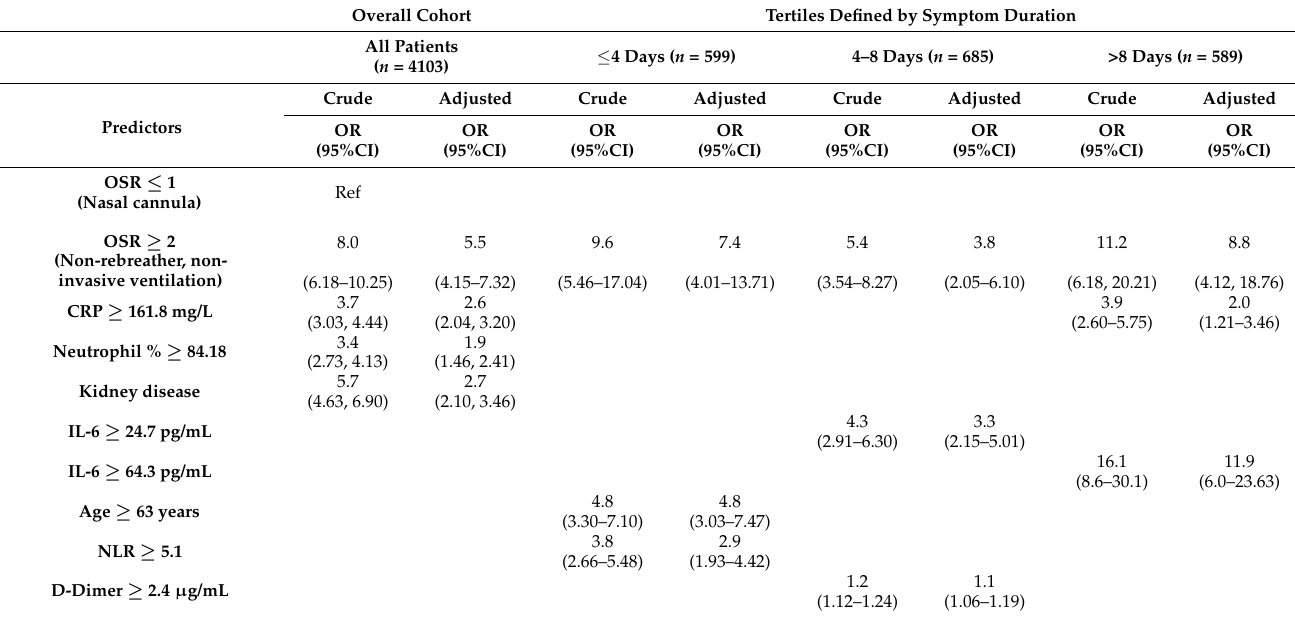
Table 2. Multivariable logistic regression model of predictive variables identified through classification tree analysis. Overall Cohort Tertiles Defined by Symptom Duration All Patients ≤ 4 Days ( n = 599) 4–8 Days ( n = 685) >8 Days ( n = ( n = 4103)